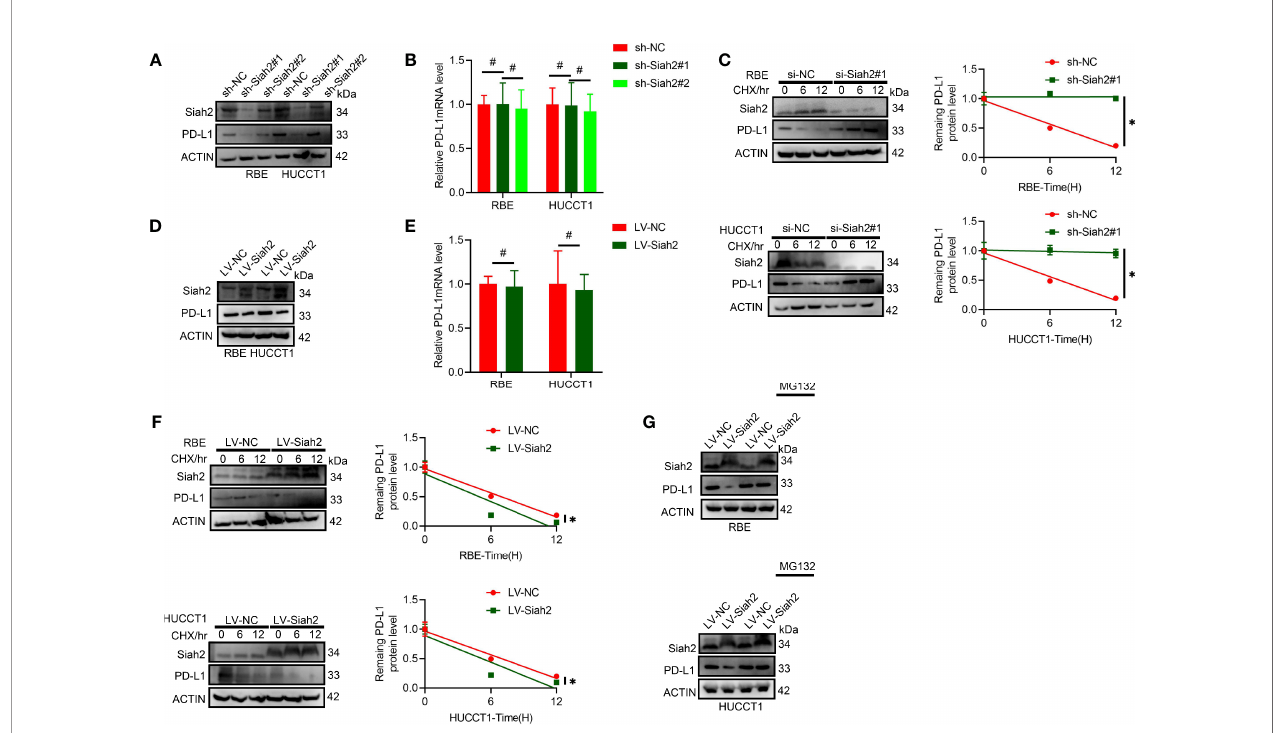
FIGURE 3 | Siah2 regulates PD-L1 stability in CCA. (A, B) , Depletion of Siah2 increases the protein level but not the mRNA level, of PD-L1 in CCA cells. (C) , Depletion of Siah2 increases the protein stability of PD-L1 under CHX treatment. (D, E) , Overexpression of Siah2 decreases the protein level, but not the mRNA level, of PD-L1 in CCA cells. (F) , Overexpression of Siah2 decreases the protein stability of PD-L1 under CHX treatment. (G) , The protein level of Siah2 was evaluated by Western blot in CCA cells with LV-NC or LV-METTL14 upon MG132 treatment. Mean±SEM of three independent experiments. *P<0.05; # P >